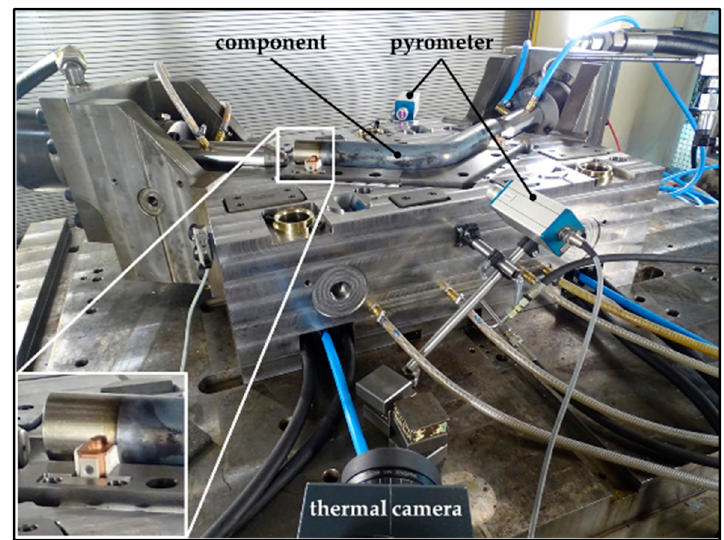
Figure 5. Bottom half of HMGF forming tool, experimental setup.